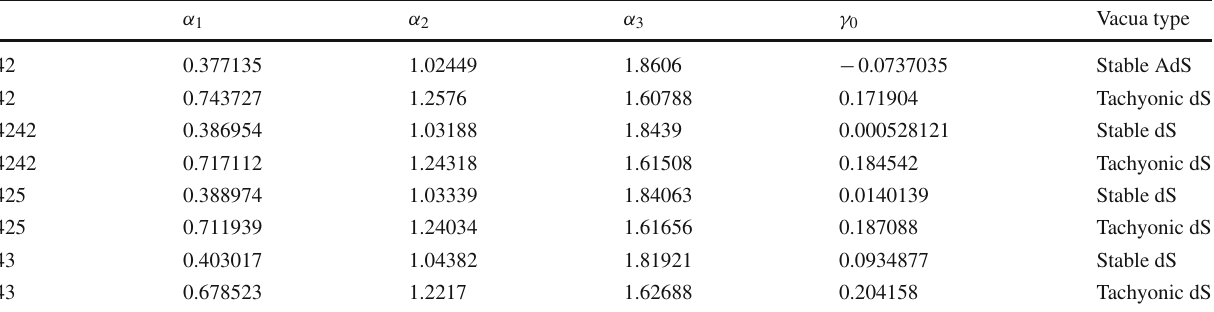
Table 6 For a chosen value of the (uplifting) parameter α 4 , the set of positive real solutions for the other three parameters { α 1 ,α 2 ,α 3 } are obtained by solving the three extremization conditions in Eq.